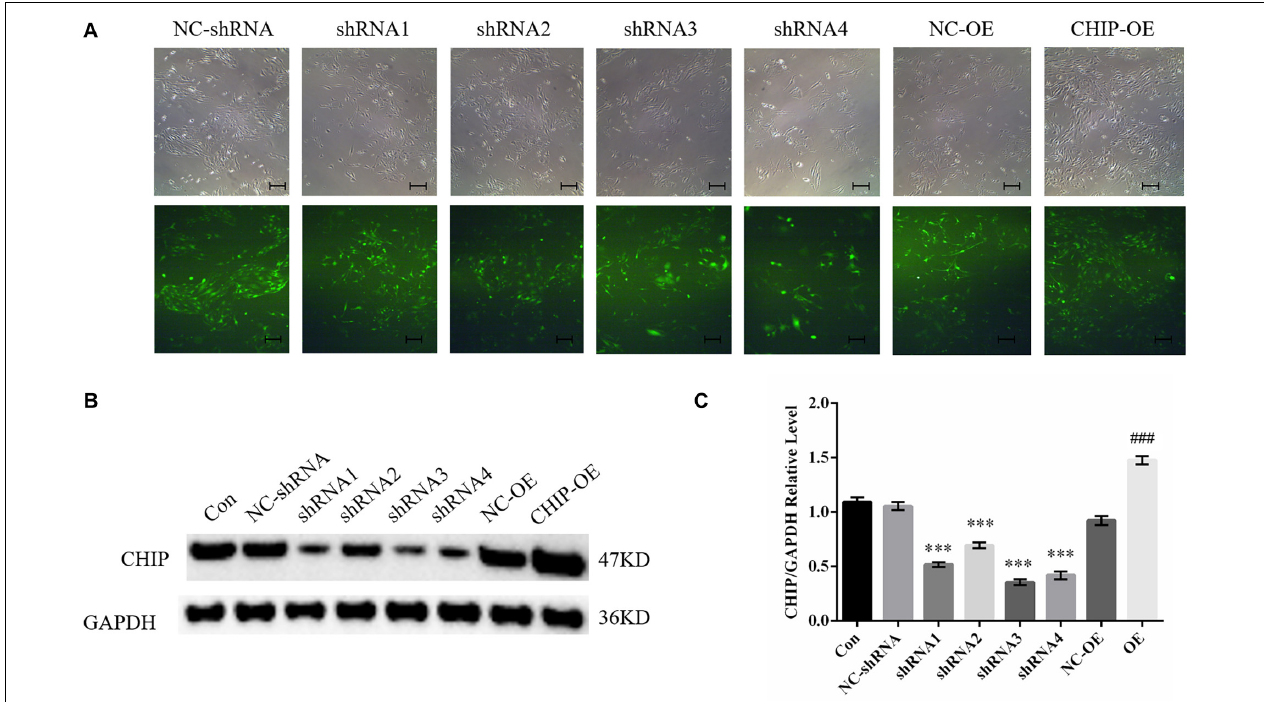
FIGURE 1 | C terminus of Hsc70-interacting protein (CHIP) overexpression and knockdown in bEnd.3 cells. (A) PCR-amplified mouse CHIP and shRNA1, shRNA2, shRNA3, and shRNA4 were cloned into lentivirus expression vectors, which contained green fluorescent protein to indicate transfection efficiency. After 48 h, the transfection efficiency was observed using fluorescence microscope. NC represented non-coding control plasmid. (B) Protein level of CHIP after overexpression and interference was tested by immunoblotting. (C) CHIP/glyceraldehyde-3-phosphate dehydrogenase relative level after overexpression and interference. ∗∗∗ p < 0.001 vs. the NC-shRNA, ### p < 0.001 vs. the NC-OE, Scale bars: 50 µ